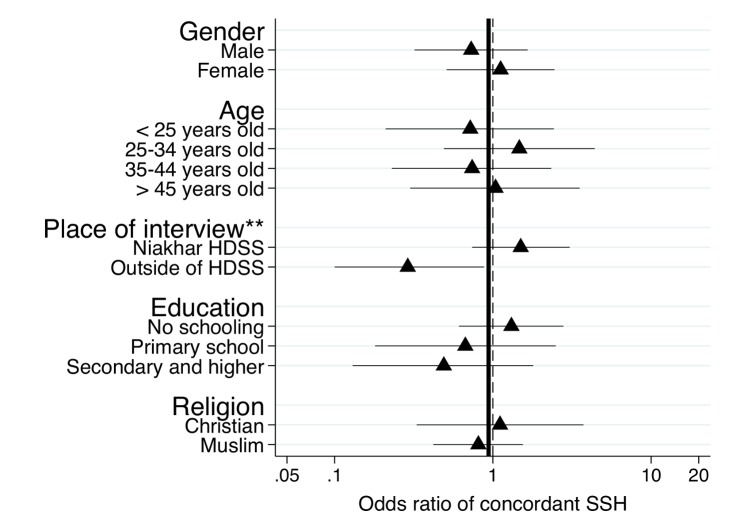
Subgroup analyses of the effects of the SSC on the sensitivity of SSH data for adult male deaths.The analytical sample for the analyses is constituted of respondents with at least one adult death among their brothers according to the HDSS dataset. The circles in the graphs represent odds ratios of reporting an adult male death associated with use of the SSC questionnaire. Error bars represent 95% confidence intervals. Estimates of odds ratios are obtained from stratified Mantel-Haenszel odds ratios. We tested for homogeneity of odds ratios across all strata of the classifying variable. The thick line represents estimates of the odds ratios for the full sample of the validation study. The dashed line corresponds to an odds ratio equal to 1. **p<0.05, tests of significance refer to the test of the homogeneity of the odds ratio across strata of the classifying variable.